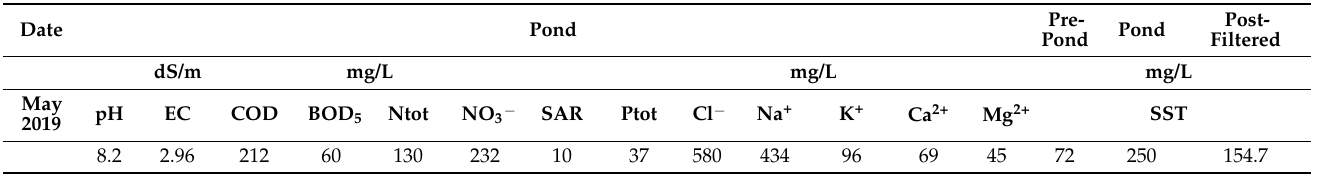
Table 1. Some chemical parameters of treated water after the pond (May 2019), and total suspended solids (SST) before entering the pond, in the pond and after sand filtration (January